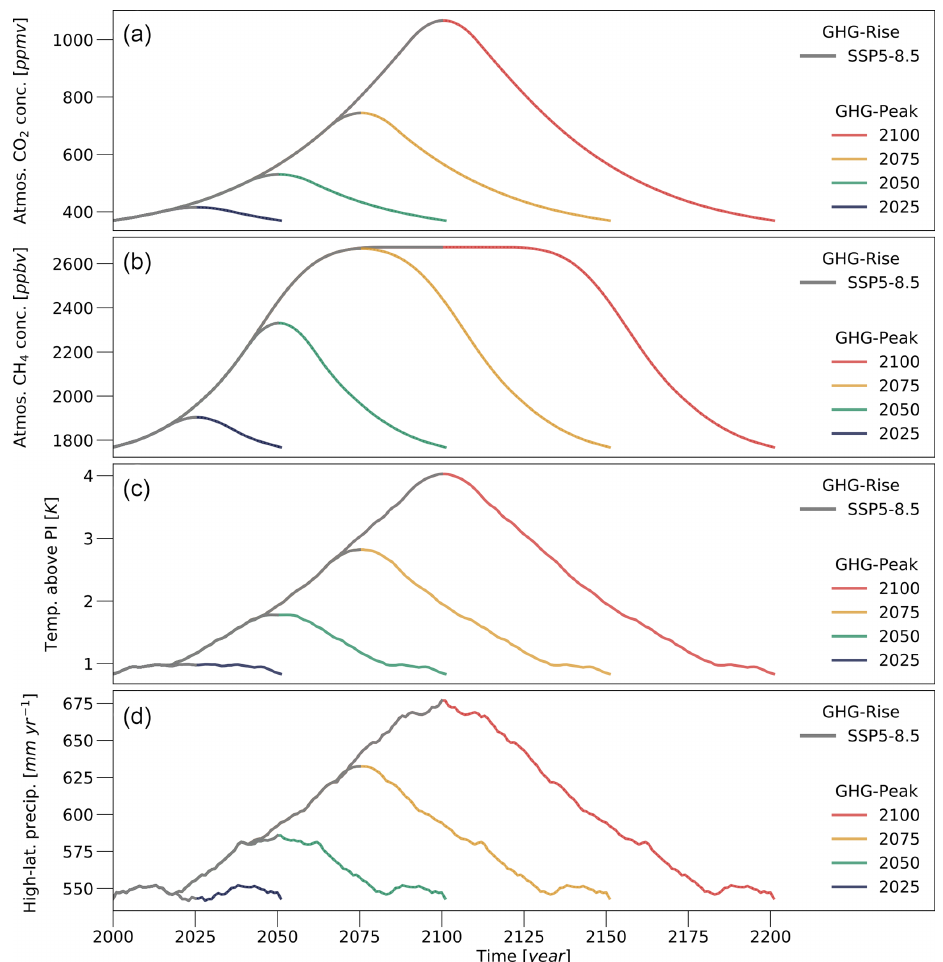
Figure 2. Experimental setup. Forcing used after the 1850–2000 spin-up phase. (a) Atmospheric CO 2 concentrations. (b) Atmospheric CH 4 concentrations. (c) Global mean surface temperature relative to the pre-industrial (PI) temperature. Note that the model is not forced by surface temperatures directly but by atmospheric temperatures at a height of roughly 30m and the surface incoming long- and short-wave radiative fluxes. (d) Precipitation rates, averaged over the latitudinal band between 60 and 90 ◦ N. Grey lines show the forcing according to the SSP5-8.5 scenario. The coloured lines show the forcing pathways that are used to reverse the forcing to the state at the beginning of the 21st century – after an assumed peak in the years 2025 (blue), 2050 (green), 2075 (yellow) and 2100 (red). In the case of temperature (and the surface radiative fluxes) and precipitation rates, the forcing was derived from CMIP6 scenario simulations with the fully coupled MPI-ESM. All panels show the 20-year moving average of the respective